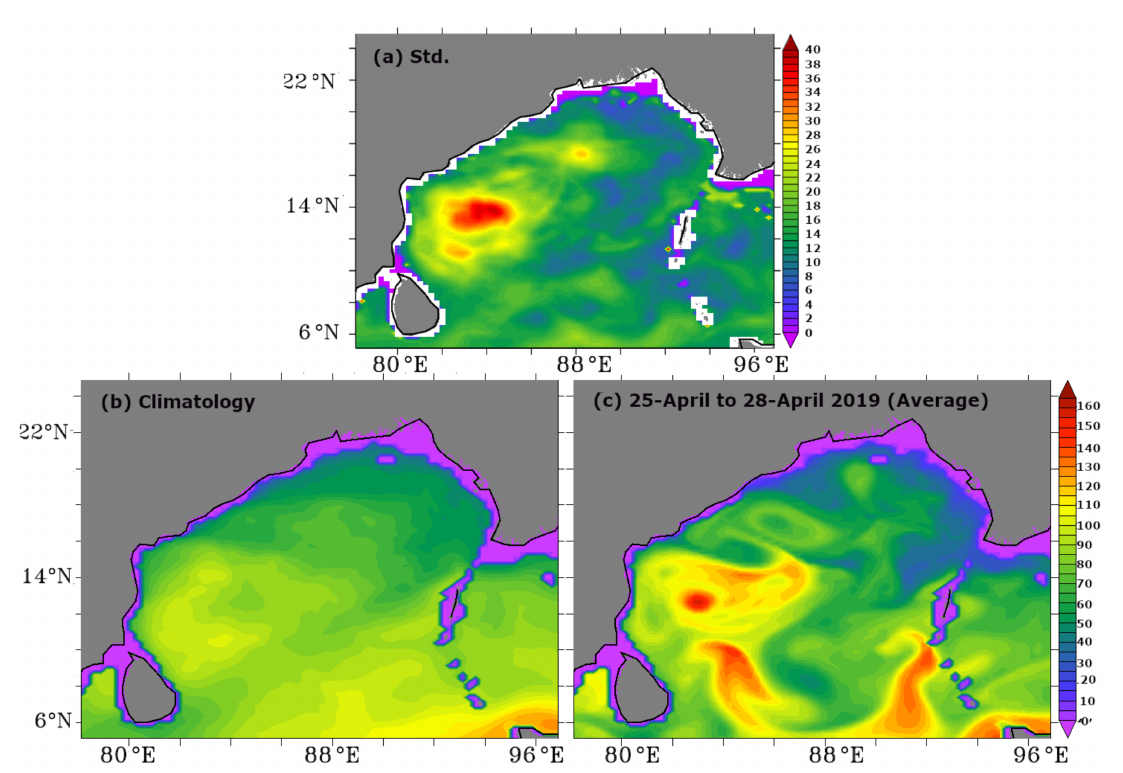
Figure 13. Along-track sea surface height anomaly (SSHA in m) (upper panel) and along-track tropical cyclone heat potential (TCHP in kJ cm − 2 ) (lower panel) for cyclones Mala, Fani, and Amphan formed over the BoB during the pre-monsoon season (April – May). Figure 8. ( a ) Standard deviation of tropical cyclone heat potential (TCHP in kJ cm − 2 ) during April for the period of 2008–2018, ( b ) climatological TCHP (kJ cm − 2 ) calculated for the 2008–2018 period for 25 April–10 May, ( c ) TCHP during the passage of Fani cyclone over the BoB (25–28 April 2019).